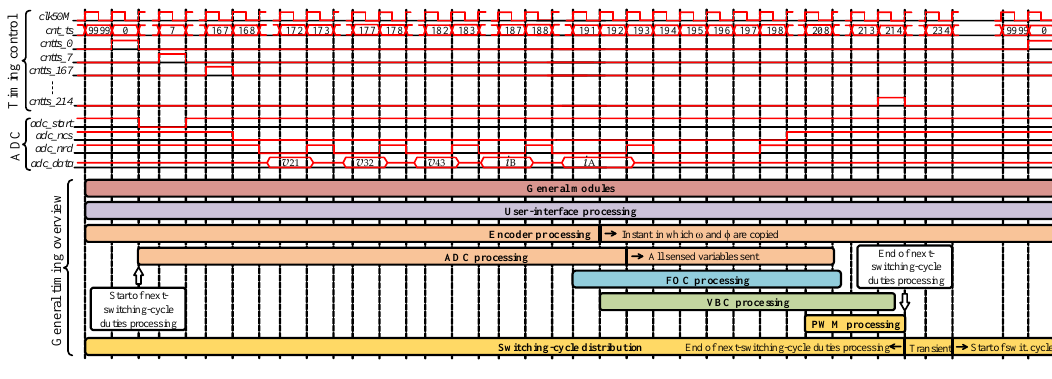
Figure 4. FPGA timing overview.